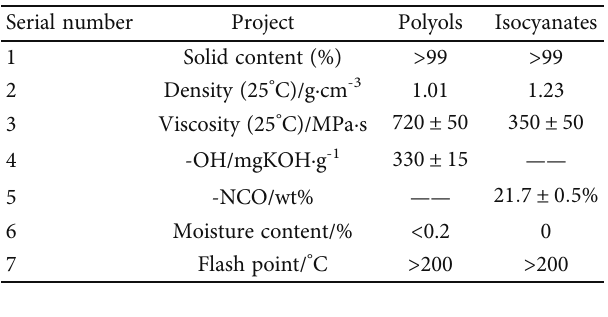
Table 1: Main component indexes of nonaqueous reactive polymer-grouting materials.